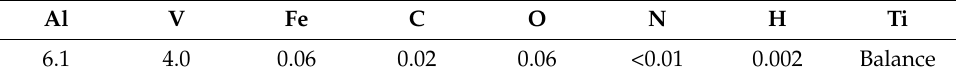
Table 1. Chemical composition of Ti6Al4V (wt.%).